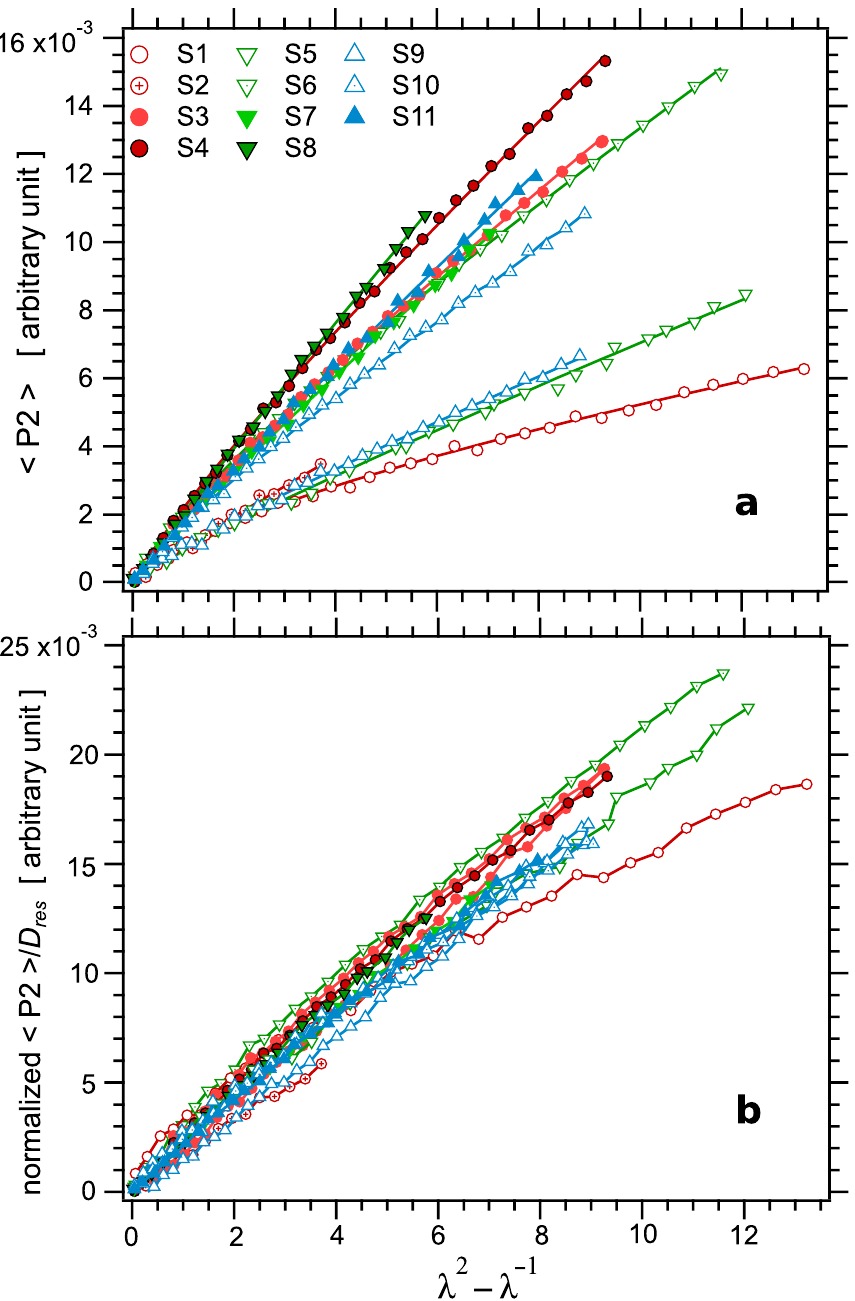
Figure 13. ( a ) Segmental orientation parameter P 2 measured in the series of unfilled samples, as a function of the elongation parameter λ 2 − λ − 1 . Symbols are experimental points, curves are Mooney– Rivlin fits, according to Equation (16). The graph illustrates the good fits which are obtained over the whole elongation range for all curves. ( b ) The normalized segmental orientation parameter P 2 / D res as a function of the elongation parameter λ 2 − λ − 1